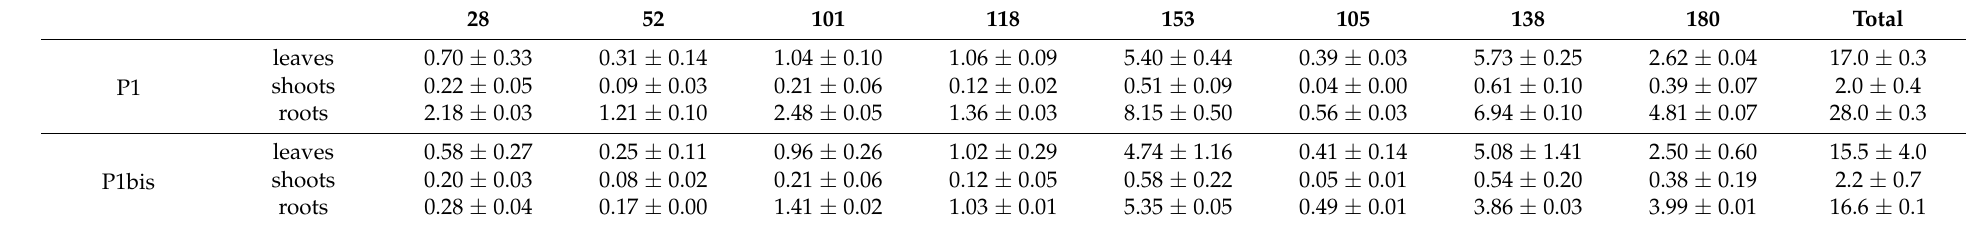
Table 4. PCB concentrations (average values expressed as ng/g ± standard deviation) detected in plant tissues at day 900 from poplar